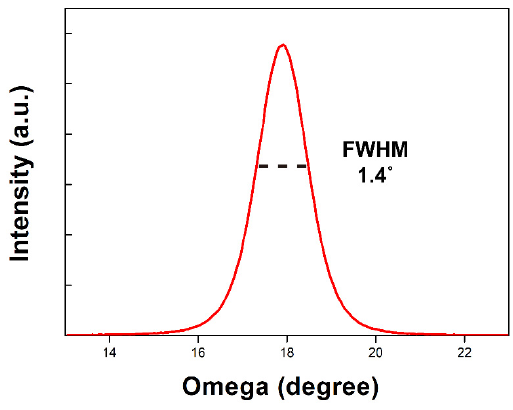
Figure 7. A rocking curve of the sputtered AlN film.